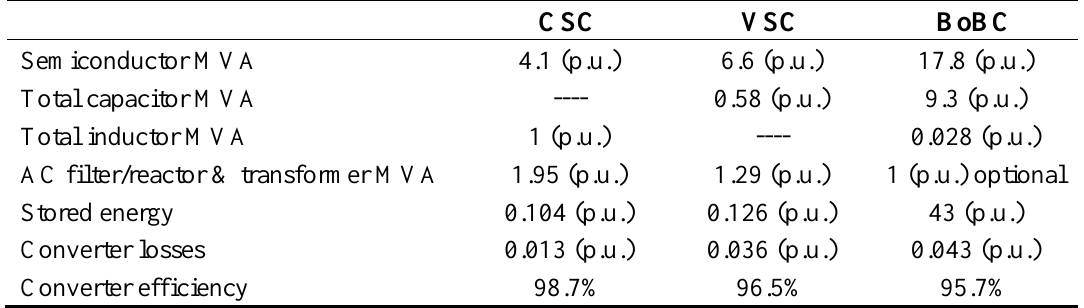
Table 11. Summary of converter quantitative characteristics for the candidate topologies.